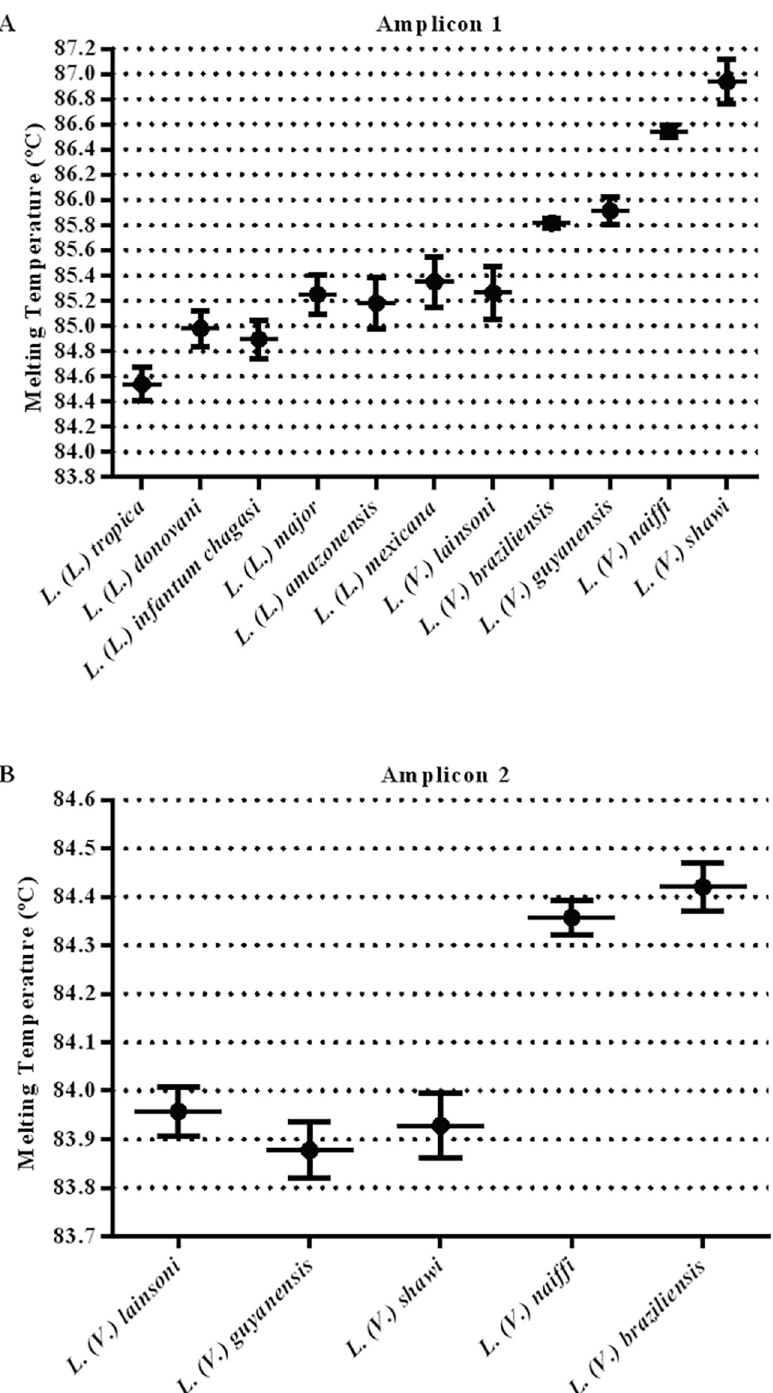
Fig 4. Effect of the amount of target DNA on the Tm values of hsp70 amplicons. Representative dispersion graph of individual Tm values for each studied Leishmania species for amplicon 1 (A) and for amplicon 2 (B). Each point corresponds to the average and standard deviation of the variation in the Tms obtained within a range of 50 ng to 50 fg of genomic DNA used as a template. Each concentration point was measured in